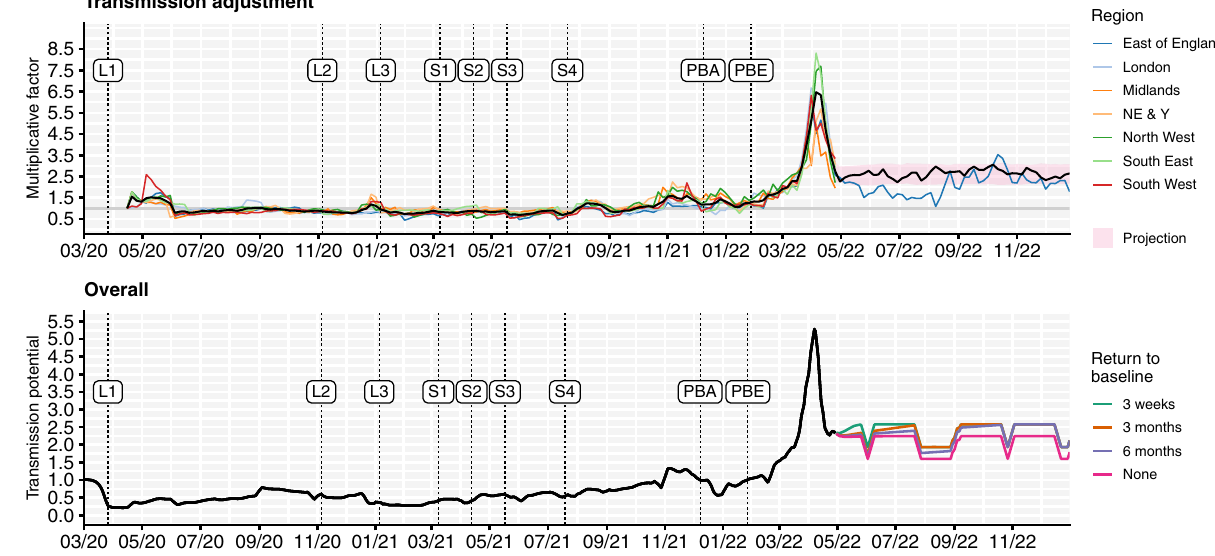
Fig. 3 | Mobility scenarios, transmission adjustments and overall transmission potential for the fi tted model, shown from March 2020 to December 2022. Top: Historic Google Community Mobility data 22 (grey) and assumed future mobility in England for no change (pink), a 3-week return to pre-pandemic baselinelevels(green),a3-monthreturntopre-pandemicbaselinelevels(orange) anda6-monthreturntopre-pandemicbaselinelevels(purple)scenariosusedfor model projections. Mobility indices are measured relative to baseline mobility levels recorded during early 2020, prior to the COVID-19 pandemic. The begin- ning of each lockdown and each roadmap Step 4 is marked with a vertical dashed line and ‘ L ’ and ‘ S ’ labels, respectively. Vertical dashed lines with ‘ PBA ’ and ‘ PBE ’ labels correspond to the announcement of ‘ Plan B ’ measures for England on 8th